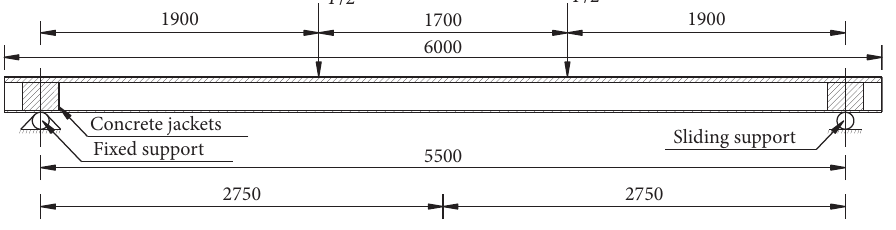
Figure 3: Side view of the GFRP-concrete hybrid structure (mm).